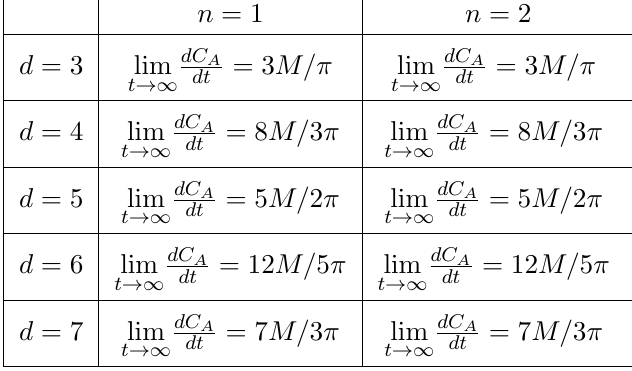
Table 1 . The late time limit of dC A =dt in various